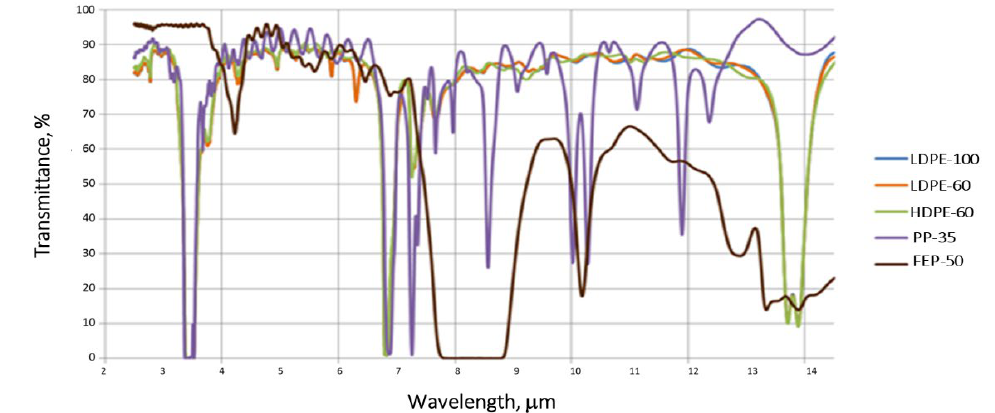
Figure 7. FT-IR spectra in the atmospheric window: 0 day samples.